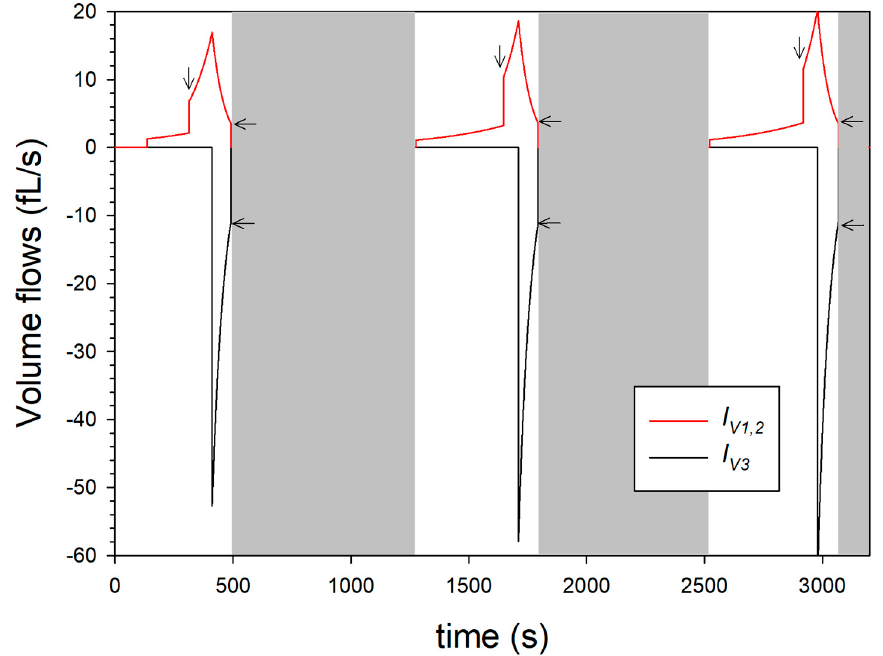
Figure 6. Simulated volume flows according to the systems dynamic model shown in Figure 4, which can be assigned to the swelling ( I V 1,2 ) or the de-swelling ( I V 3 ) of the microparticle.